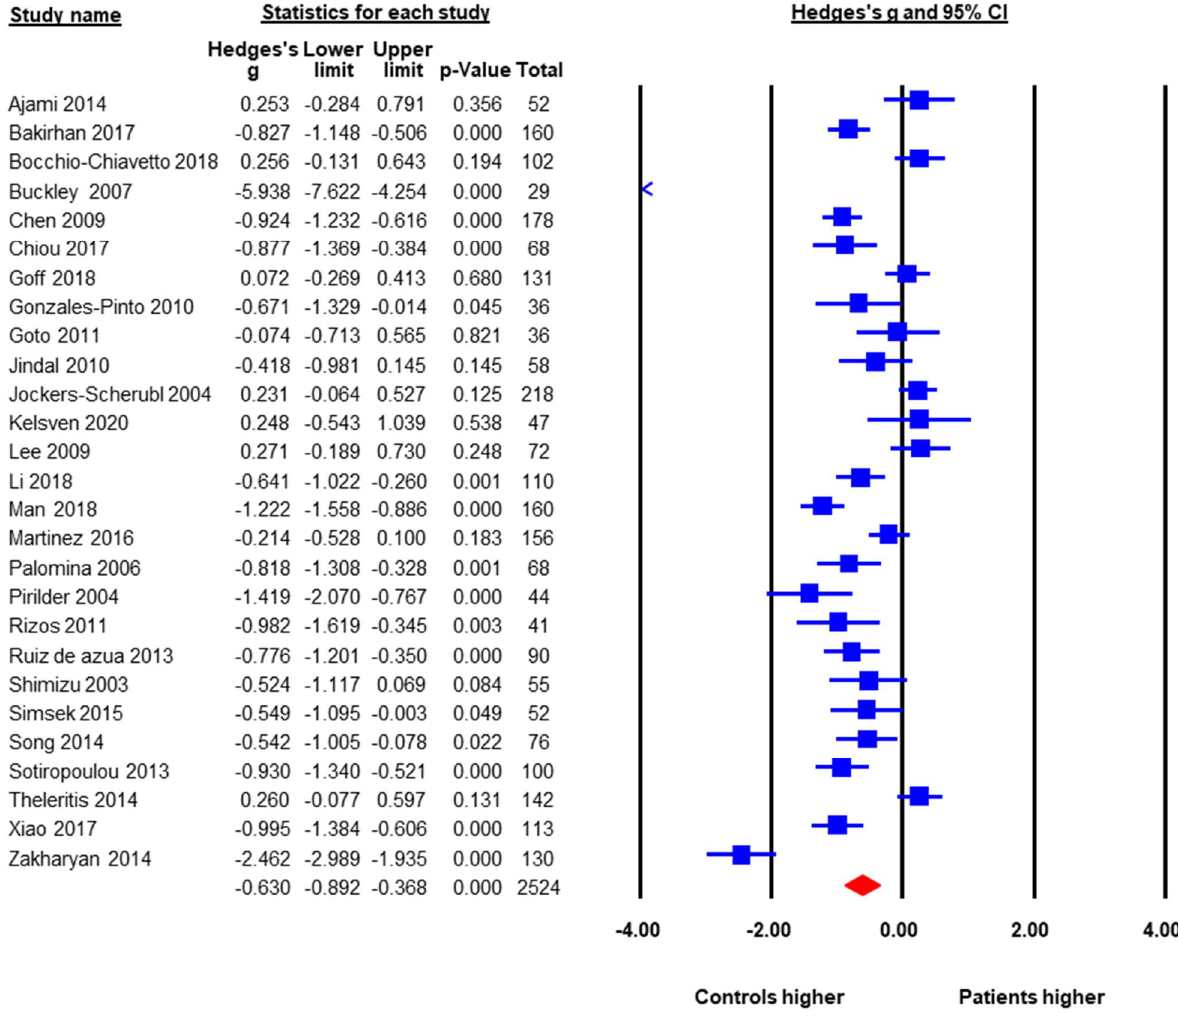
Figure 2. Peripheral BDNF Levels in First Episode Psychotic Patients versus Healthy